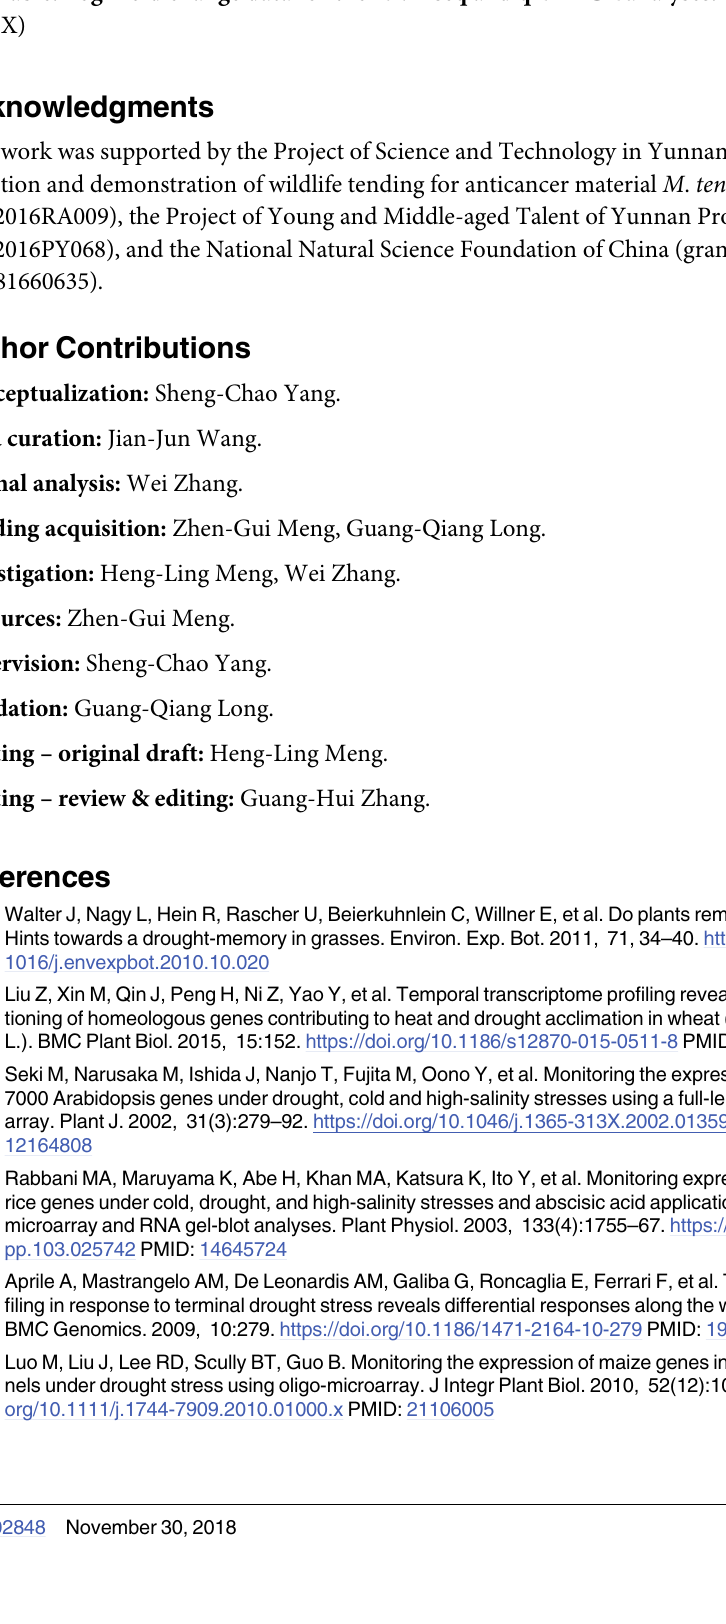
S9 Table. Genes that were up-regulated under drought stress and down-regulated after re- watering treatment. S10 Table. Log2 fold change data for the RNA-seq and qRT-PCR